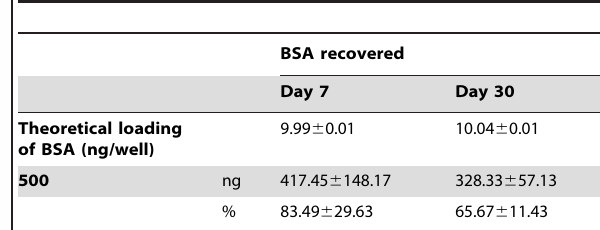
Table 8. In vitro analysis of BSA release from 10 w/w SA MNs into solution, where the results were obtained using the BCA method (means 6 SD, N=4, four different BSA-loaded microneedle arrays were used in 4 different vials, and duplicate measurements of each vial at each time period were